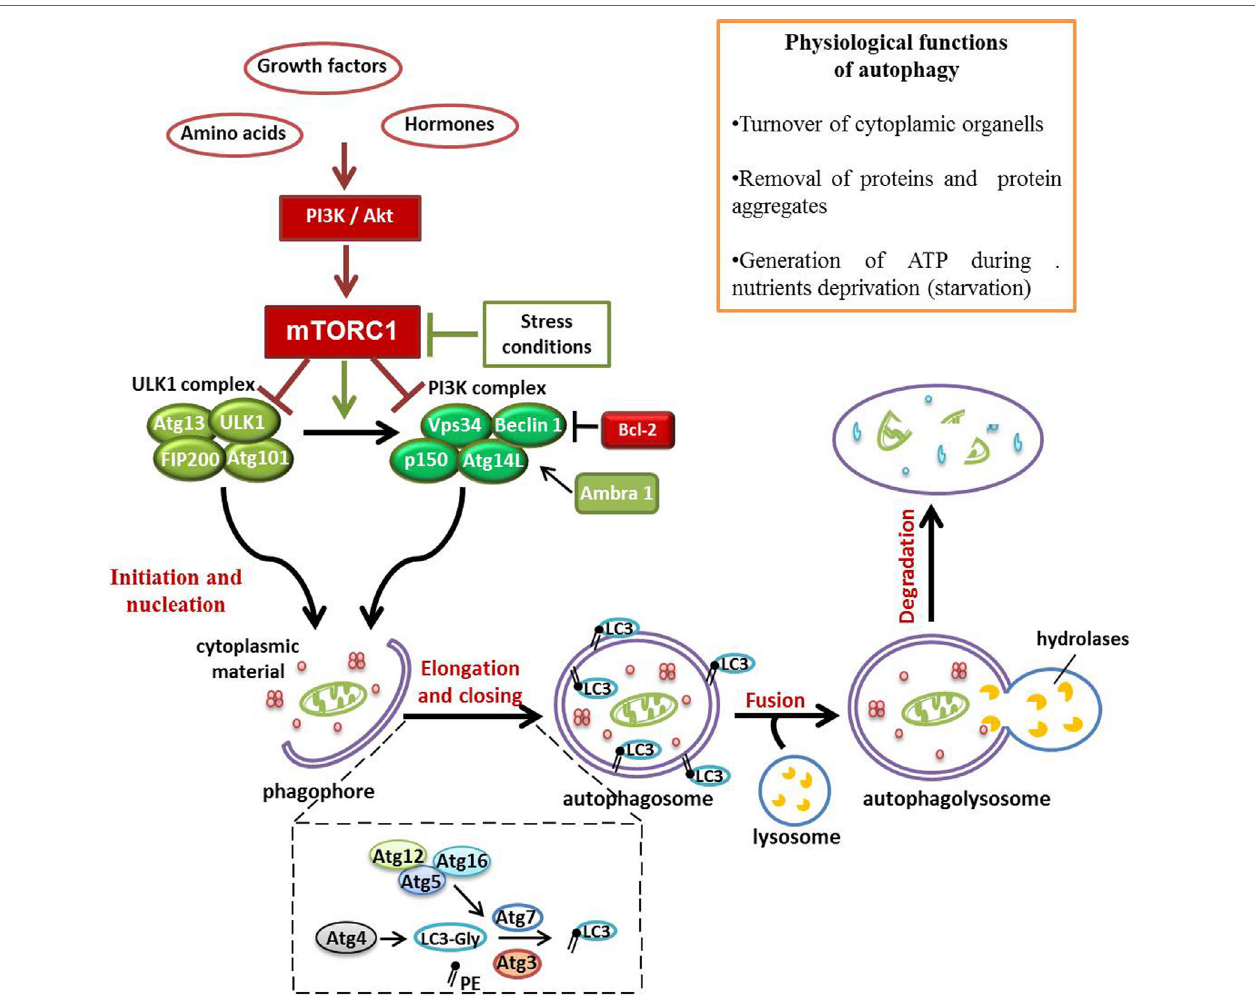
FiGURe 1 | Schematic representation of signaling pathways involved in autophagy multistep regulation. Autophagy represents a fundamental physiological process, considering its role in ATP production during condition of nutrients deprivation and in controlling organelles and proteins turnover. mTOR complex 1 (mTORC1), acting as a sensor of energy levels and integrating upstream signals [phosphoinositide 3-kinase (PI3K) and Akt], is one of the most important autophagy regulators in cells. In presence of growth factors and hormones, mTORC1 inhibits autophagy activation. On the contrary, in autophagy-activated conditions, the repression of mTORC1 activity allows autophagy initiation by ULK1 and PI3K complexes recruited to the just formed phagophore. This pre-autophagosomal structure begins to engulf cytoplasmic materials and, thanks to Atg12–Atg5–Atg16L and LC3–phosphatidylethanolamine conjugated systems, it grows up and closes to generate the autophagosome. The fusion of the autophagosome with lysosome exposes the cargo to the action of lysosomal hydrolases that degrade vesicular content for recycling.